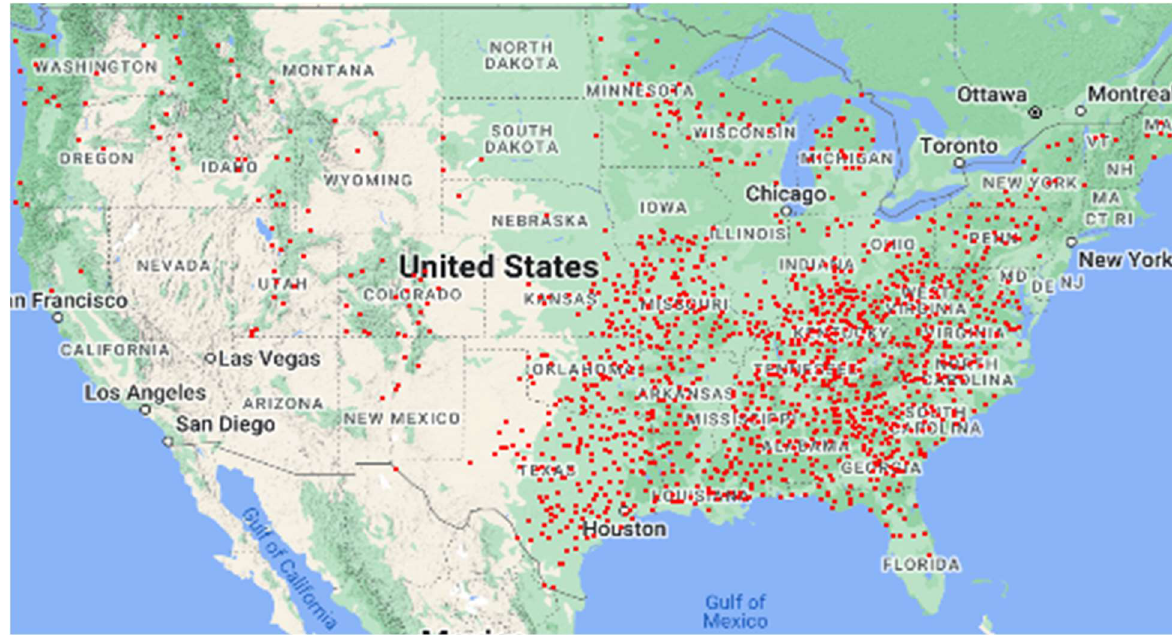
Figure 3. Cluster 1 (1395 counties from 40 different